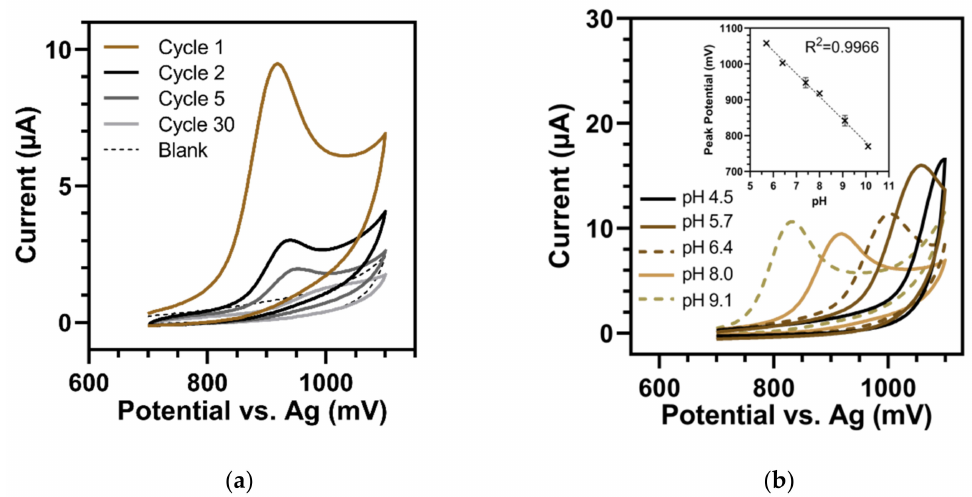
Figure 2. Cyclic voltammetry of 125 µ M HHQ (100 mV/s). ( a ) First 30 cycles in buffer of pH 8.0. In the first cycle (brown), one defined oxidation peak at 918 mV occurred. In the following cycles (black to light grey), the oxidation peaks rapidly dropped. Blank = pH 8.0 buffer. ( b ) Dependency of HHQ on pH of the buffer solution. In acid buffers ( ≤ pH 5.0), no oxidation peaks could be seen, i.e., could not be separated from the peaks of water electrolysis. Insert: Shift in oxidation peak potential versus pH (pH 5.7 to 10.1). Error bars represent the standard deviations of three